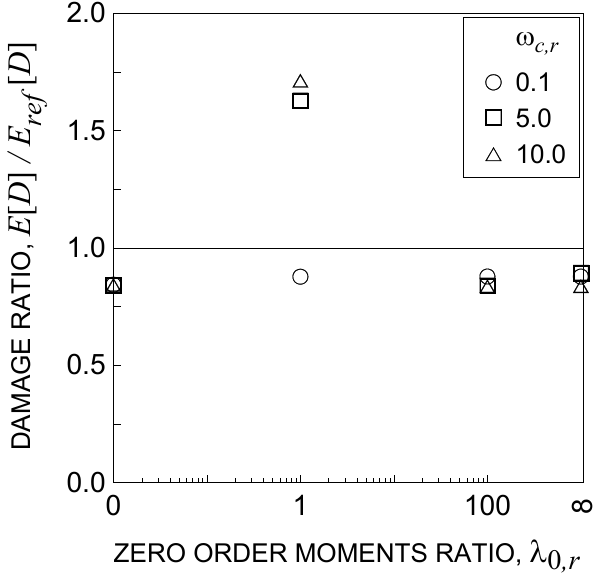
E D : totally separated spectra. ref